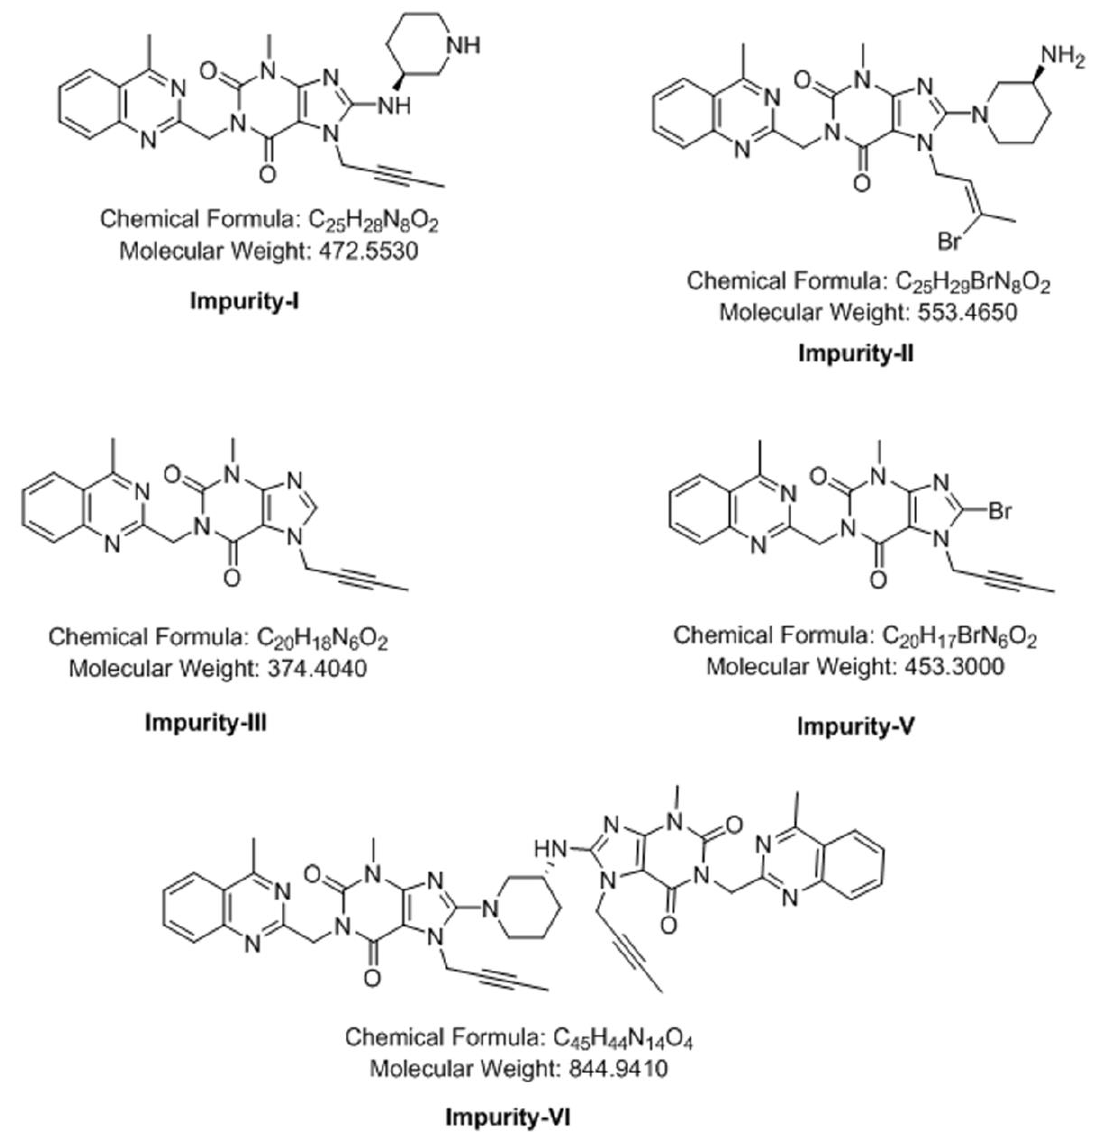
Scheme 3. Process-related impurities including molecular formula and molecular